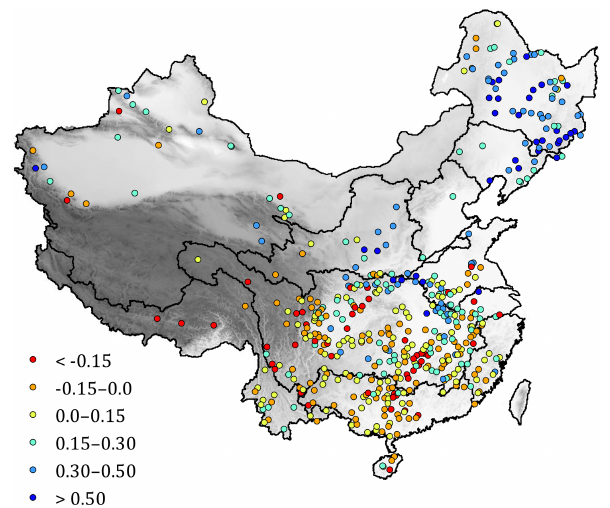
Figure 7. Map of the GEV shape parameters for the stationary time series (i.e., no significant change points in mean or in variance or monotonic trends) of annual flood peaks.